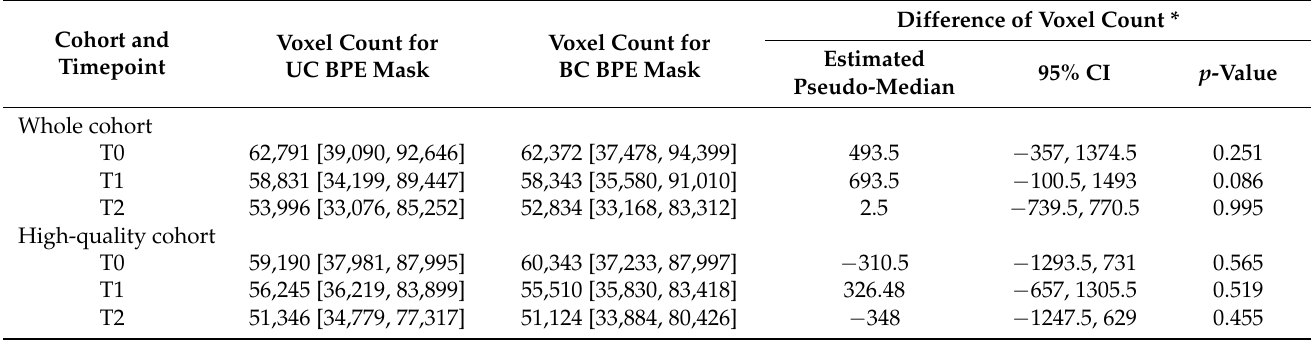
Table 3. Voxel count before and after bias-correction.